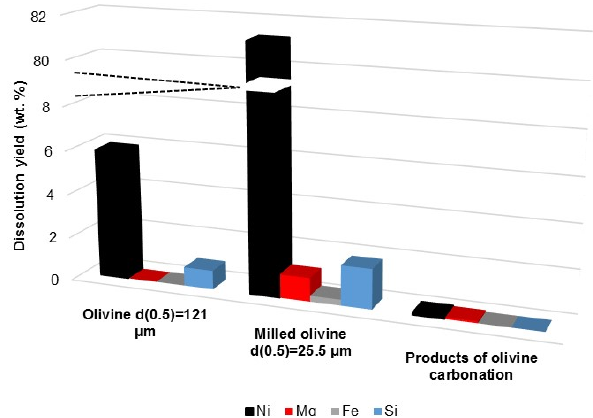
Figure 2: Dissolution yield of olivine and carbonation products using ammonia solution.